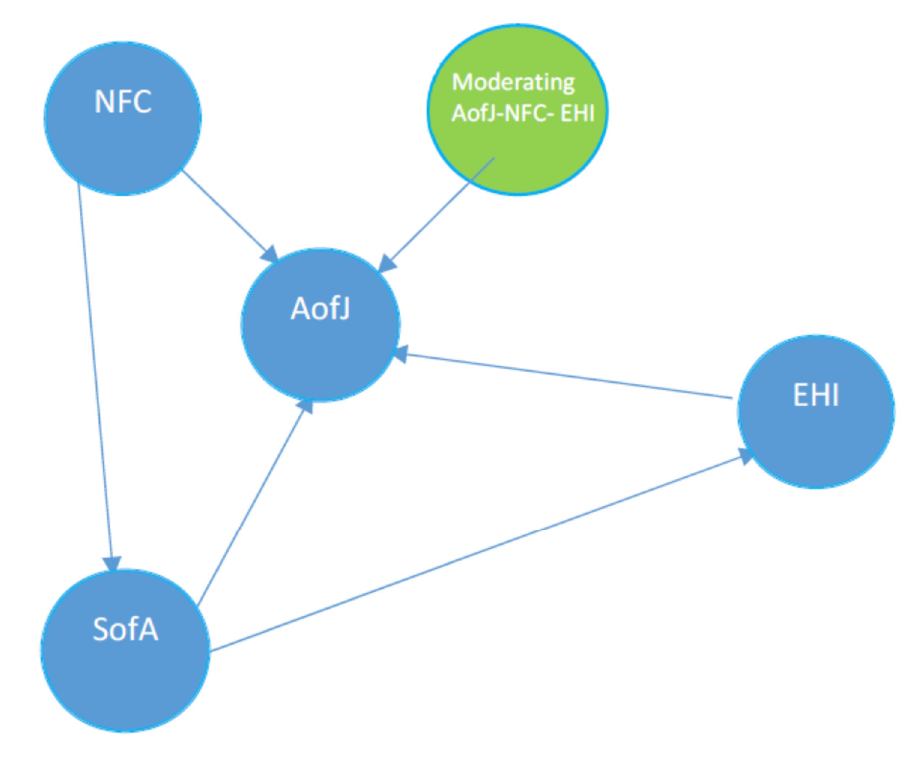
Figure 1. The theoretical model of the research. AofJ-the attractiveness of jobs in the hospitality industry for young people; EHI-evolution of the hospitality industry after the end of the COVID-19 period; NFC-the COVID-19 pandemic is a negative factor that initiates change in the hospitality industry; SofA-a job in the hospitality industry is motivated by the spirit of youth adventure.